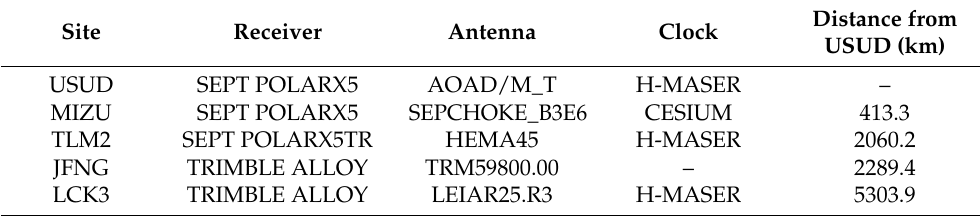
Table 2. Information of selected stations.